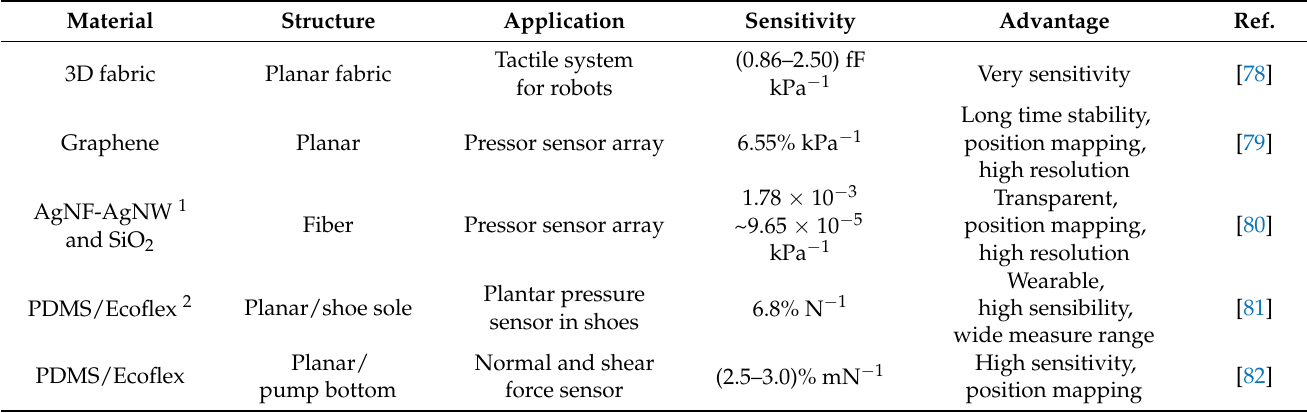
Table 2. Comparative sensing performances of the piezocapacitive-based sensor.